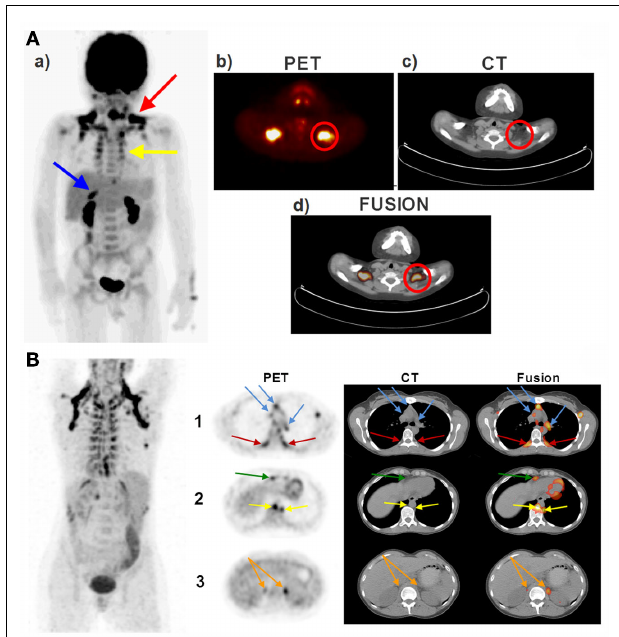
FIGURE 1 | Brown adipose tissue (BAT) distribution in a pediatric (A) and adult (B) human. (A) The PET/CT scans of a 5-year-old boy taken 60min after an i.v. injection of 5mCi 18 FDG. Red arrow shows the supraclavicular BAT, yellow arrow shows the peri-spinal BAT depots and blue arrow shows the peri-adrenal BAT depot in (a) coronal view (postero-anterior projection).The Supraclavicular BAT is also illustrated in a transversal series of (b) PET, (c) CT, and (d) fusion views of the cervical–supraclavicular region. Red circles denote the supraclavicular BAT in (b–d) . (B) The PET/CT scans of a 35-year-old woman taken 60min after an i.v. injection of 5mCi 18 FDG. First row shows the transversal section of the aortic arch. Red arrows denote the peri-spinal BAT depots and the blue arrows point to the mediastinal BAT depots on PET (left panel), CT (middle panel), and fusion scans (right panel). Second row shows the transversal section of the hepatocardiac section, where yellow arrows point to the peri-aortic BAT depots and the green arrow points to the pericardial BAT depots.Third row shows the transversal section of the adrenal gland, where orange arrows point to the peri-adrenal BAT depots. PET/CT, positron emission tomography/computed tomography; 18 FDG, 18 fluorodeoxyglucose; i.v., intravenous; BAT, brown adipose